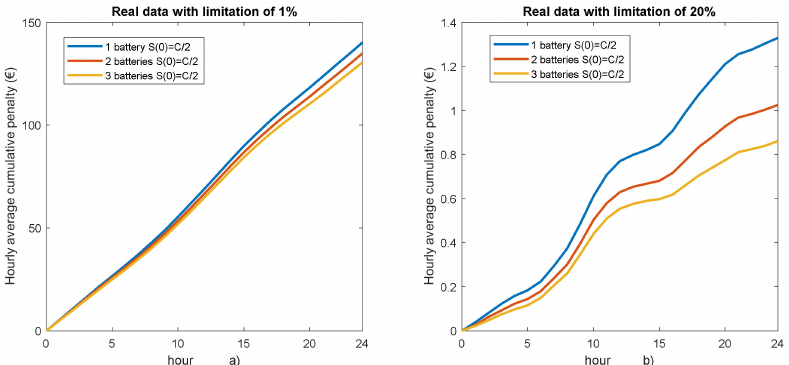
Figure 10. Hourly average cumulative penalty in 1 day with the ramp-rate percentage limitations of 1% ( a ) and 20% ( b ).